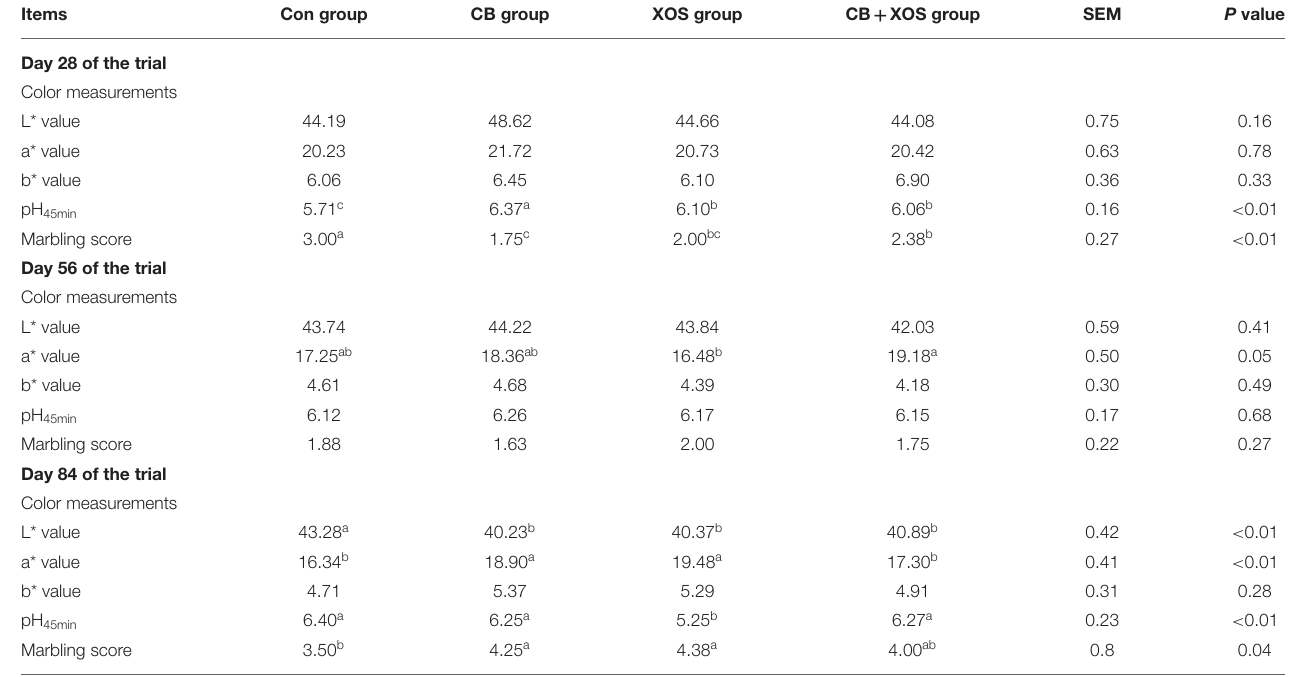
TABLE 4 | Effects of dietary addition with CB and XOS on meat quality of Huanjiang mini-pigs.